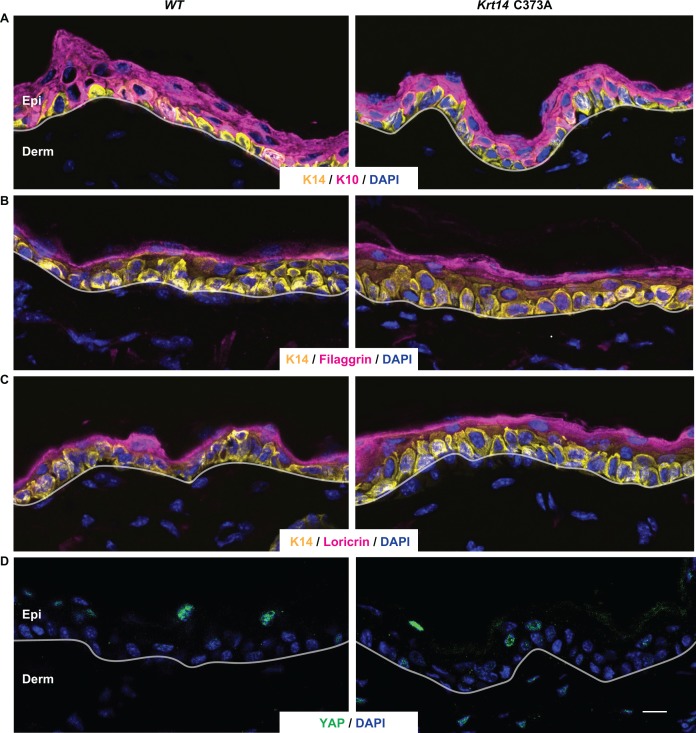
Analysis of terminal differentiation in mouse back skin tissue.(A-C) Cryosections of back skin tissue from young adult WT and Krt14 C373A were subjected to dual indirect immuno-fluorescence using antibodies to (A) K14 and K10; (B) K14 and filaggrin; and (C) K14 and loricrin. (D) Same as A, except that an antibody to Yap1 was used. Unlike the case for tail and ear skin tissue (see Figures 2 and 3), Krt14 C373A epidermis exhibits a normal thickness, a normal distribution of differentiation markers. Consistent with the literature (Beverdam et al., 2013), YAP1 staining is much reduced and not confined to the basal layer in back skin epidermis. Nuclei are stained with DAPI (blue), and dashed lines depict the dermo-epidermal interface. Epi, epidermis; Derm, dermis. Scale bar, 20 µm.